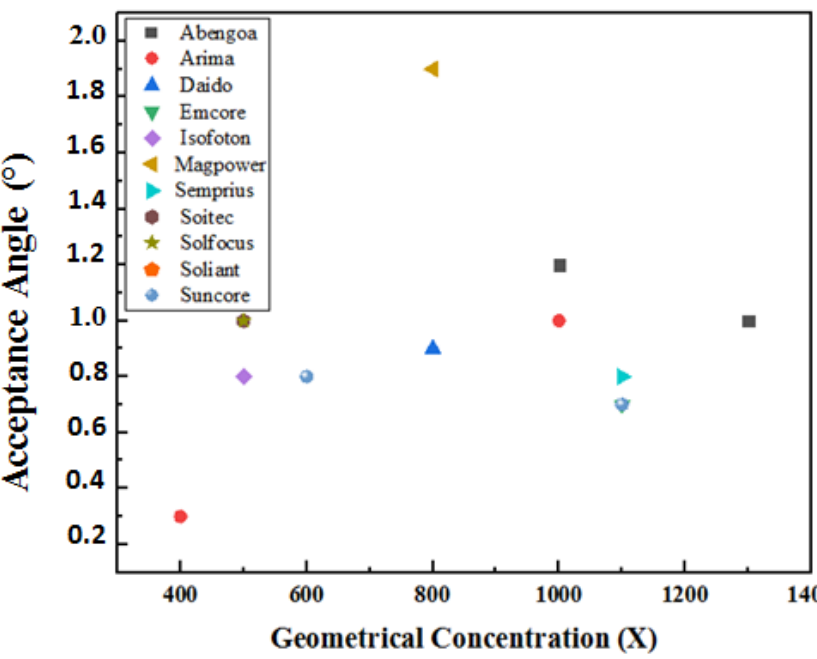
Figure 44. Acceptance angles of commercial modules with respect to geometric